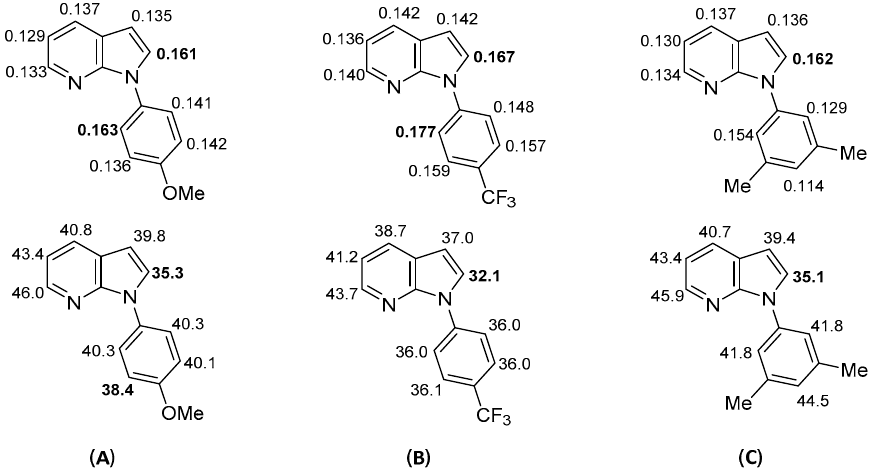
Figure 5. Calculated H charges (top) and p K a values (bottom) of 1-(4-methoxyphenyl)-7-azaindole